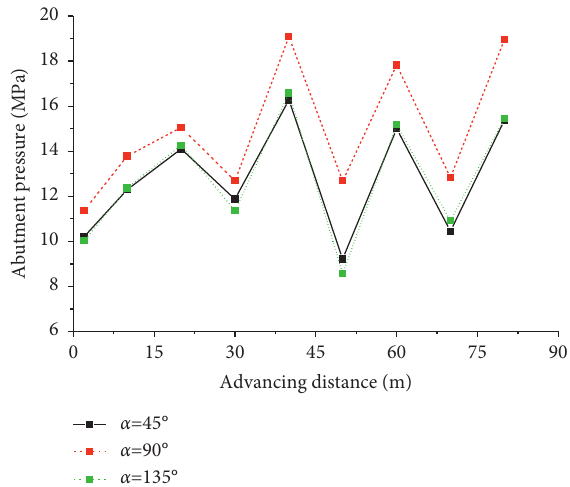
Figure 16: Abutment pressure distribution in the limit equilibrium area with different joint inclination angles.